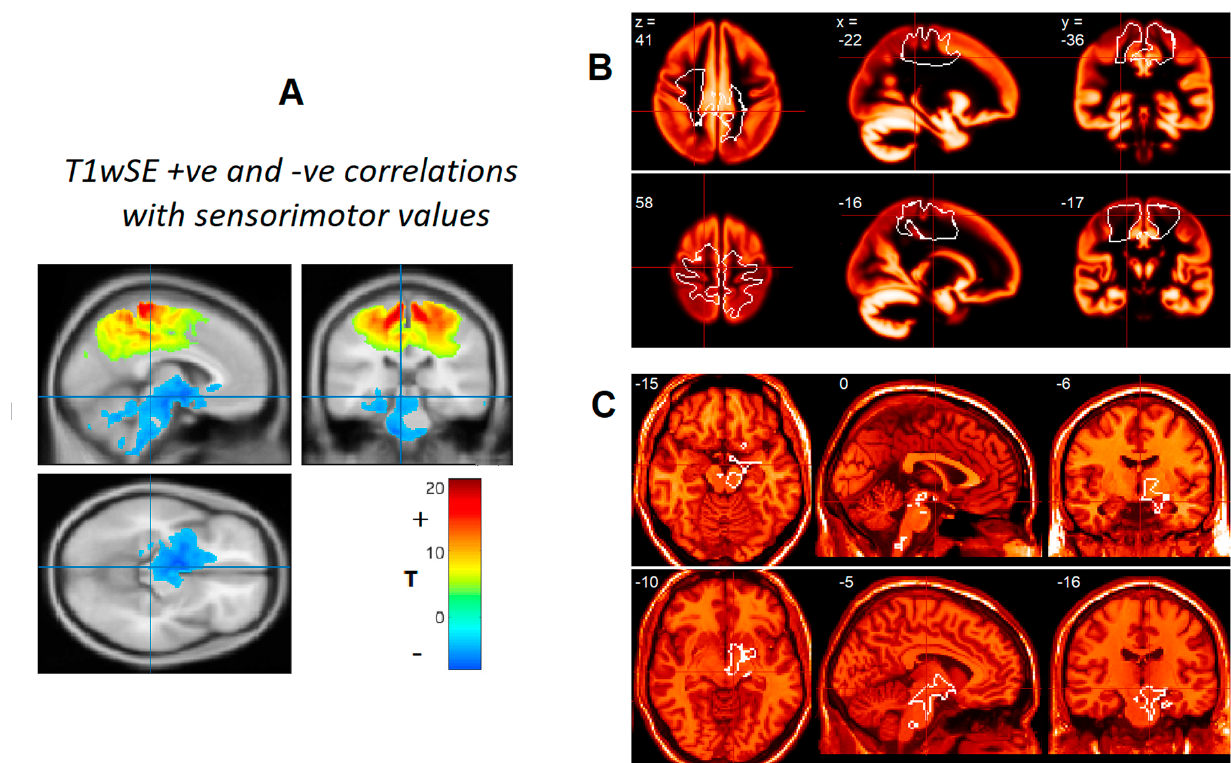
Figure 1. Sensorimotor and Subcortical ROIs. ( A ) Clusters shown as maximum and minimum T value projections from positive (superior) and negative (inferior) voxel-wise T1wSE self-correlations with sensorimotor levels. The threshold for cluster formation was p = 0.0001. ( B ) Edges (in white) of the sensorimotor ROI formed by thresholding the positive correlation cluster at T = 7.0 ( p = 1 × 10 − 9 ) shown on sections of the grey matter tissue probability map from SPM12. The low probability dark areas within the ROI are white matter (WM), so most of the ROI is either WM or intermediate probability WM. ( C ) Edges of the subcortical ROI formed by thresholding the negative correlation cluster at T = 5.0 ( p = 2 × 10 − 6 ) shown on sections of the single subject T1 reference from SPM12. The subcortical ROI includes the neurons and connections of the brainstem cuneiform, dorsal Raphe, pontine and medulla RAS nuclei, the left VTA, posterior hypothalamus, amygdala and hippocampus. Edge voxels are within the ROIs.